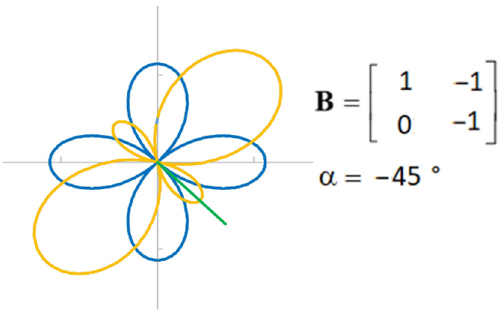
Figure 10. General tensor with 𝛼 = −45° .